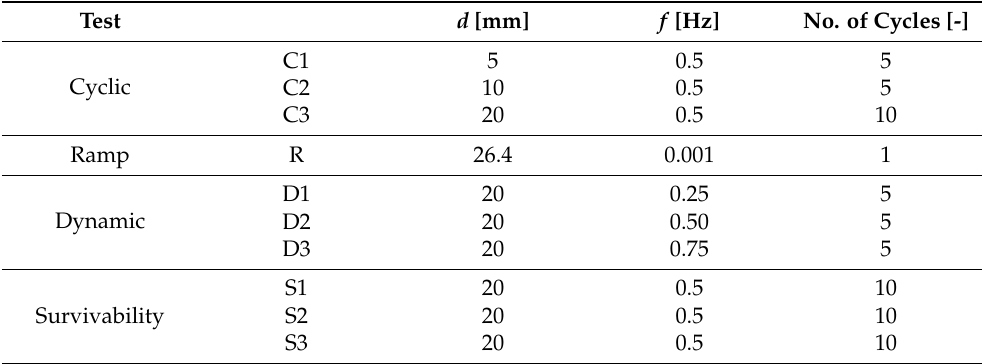
Table 1. Testing protocol according to the EN 15129